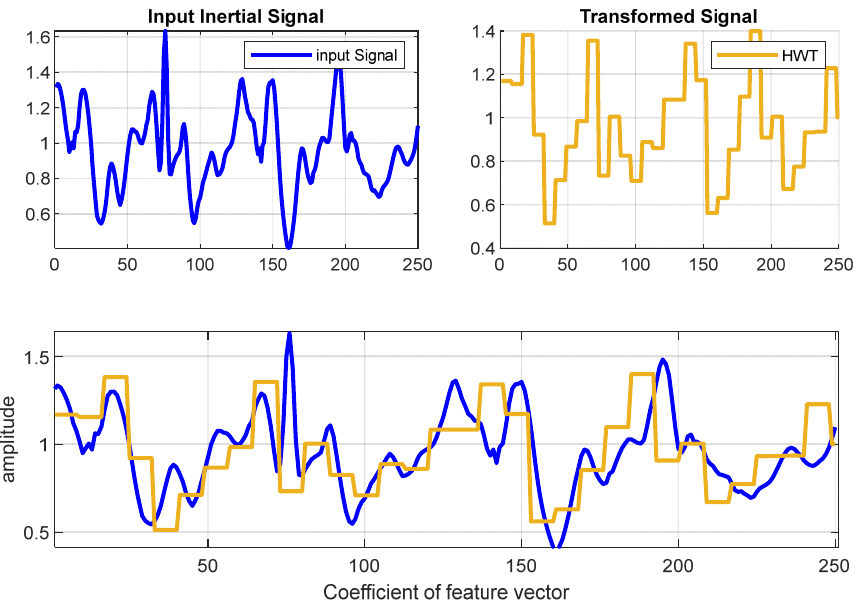
Figure 5. The 1D-HWT feature of the inertial signal feature plot from daily activity (walking) from the USC ‐ HAD dataset .